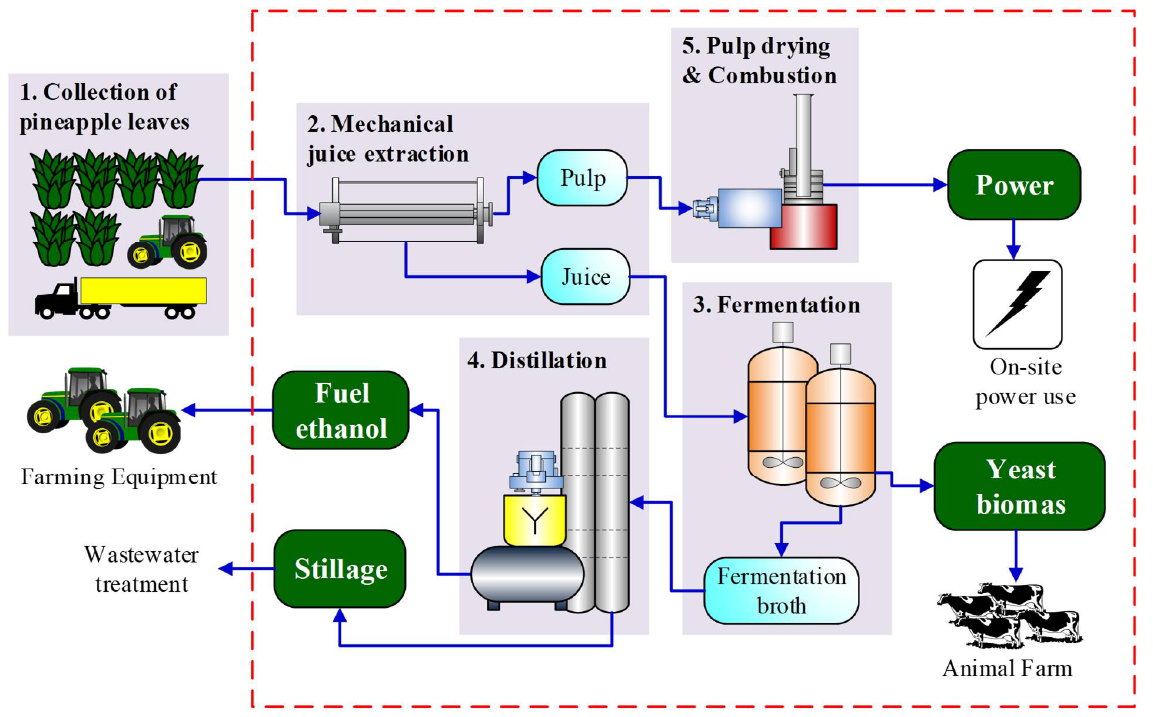
Figure 1. Pineapple leaf biorefining *. *: The red frame is the boundary for the life cycle assess-